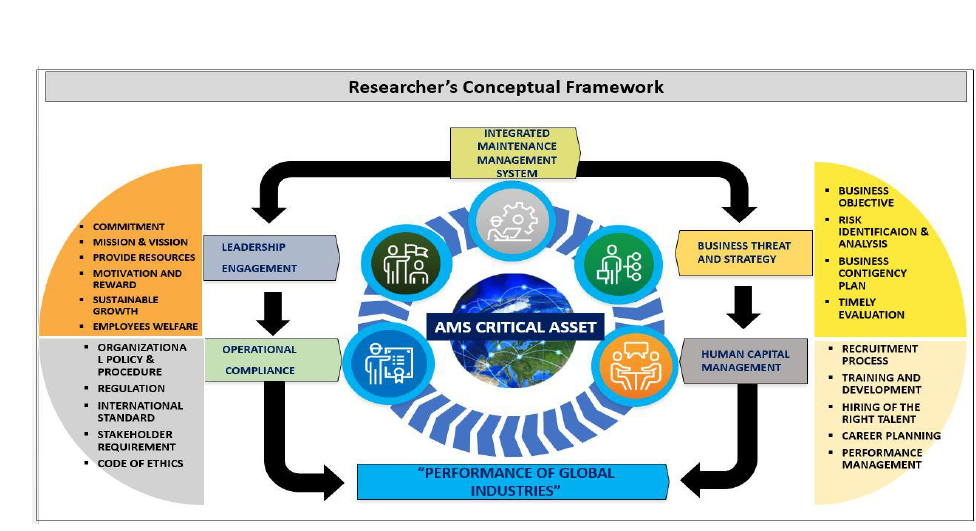
Figure 1. The assurance management system for critical asset model (AMSCAF